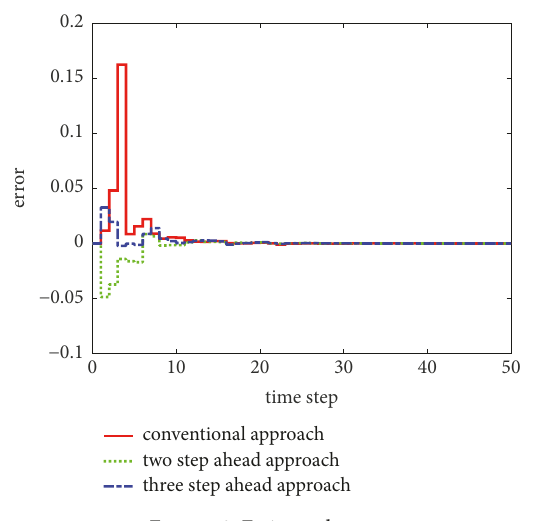
Figure 2: Estimated error.